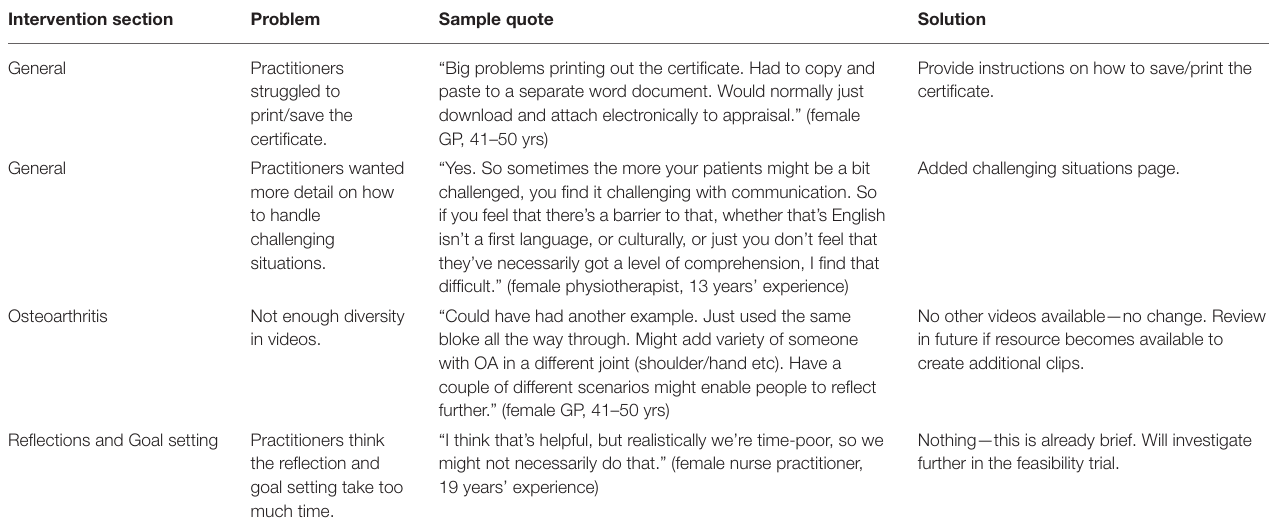
TABLE 8 | Illustrative examples of problems and solutions identified through “table of changes” analysis of interviews with practitioners who had tried Empathico. Intervention